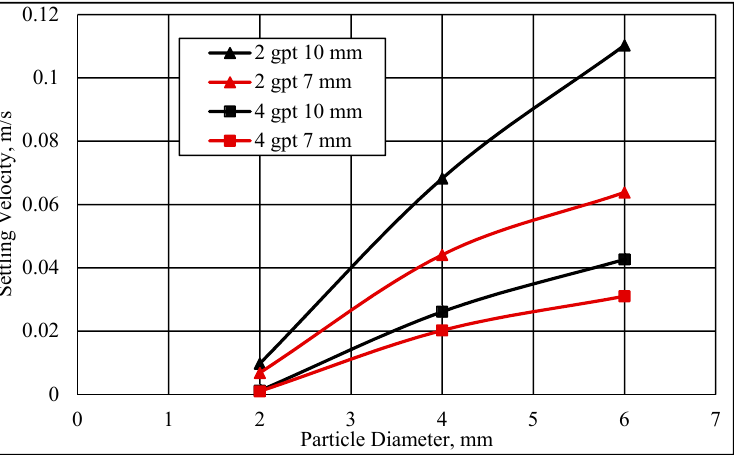
Figure 13. Terminal settling velocity of spherical particles using two fracture widths and two friction reducer concentrations.